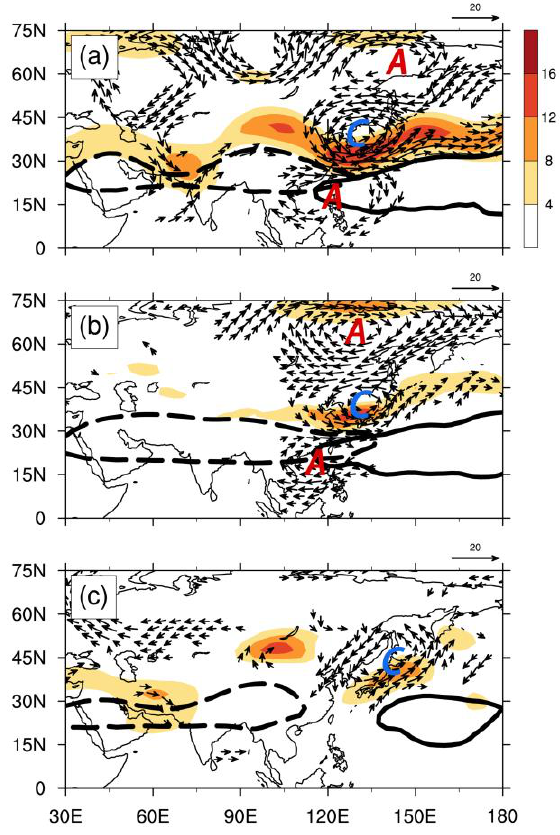
Figure 7. Composite averaged horizontal wind anomalies at 500 hPa (vector; units: m s −1 ) and anomalous U-wind at 200 hPa (shading; units: m s −1 ) of ( a ) EAP/SR-C; ( b ) EAP-S; and ( c ) SR-S events. The dashed contours (1250 dagpm-contour) and thick black contours (588 dagpm-contours) denote the activities of the SAH at 200 hPa and WPSH at 500 hPa. The letters ‘C’ and ‘A’ represent anomalous cyclone and anticyclone, respectively.